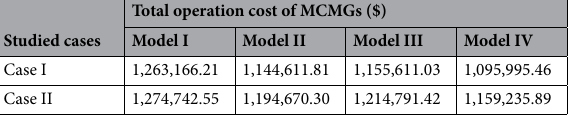
Table 1. Numerical financial information for the operation of MCMGs in different